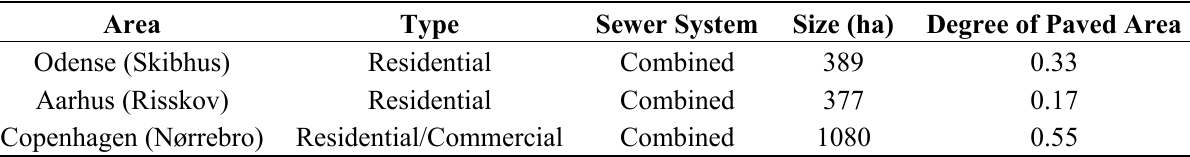
Table 3. Main characteristics of the case study